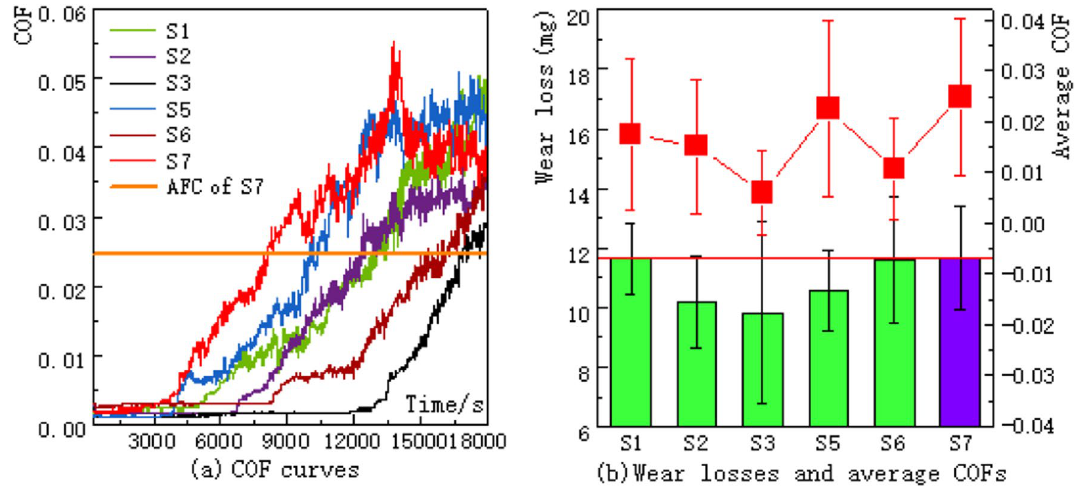
Figure 4. COF curves, wear losses and average COFs of groups (S1–S3, S5–S7) under starved lubrication.